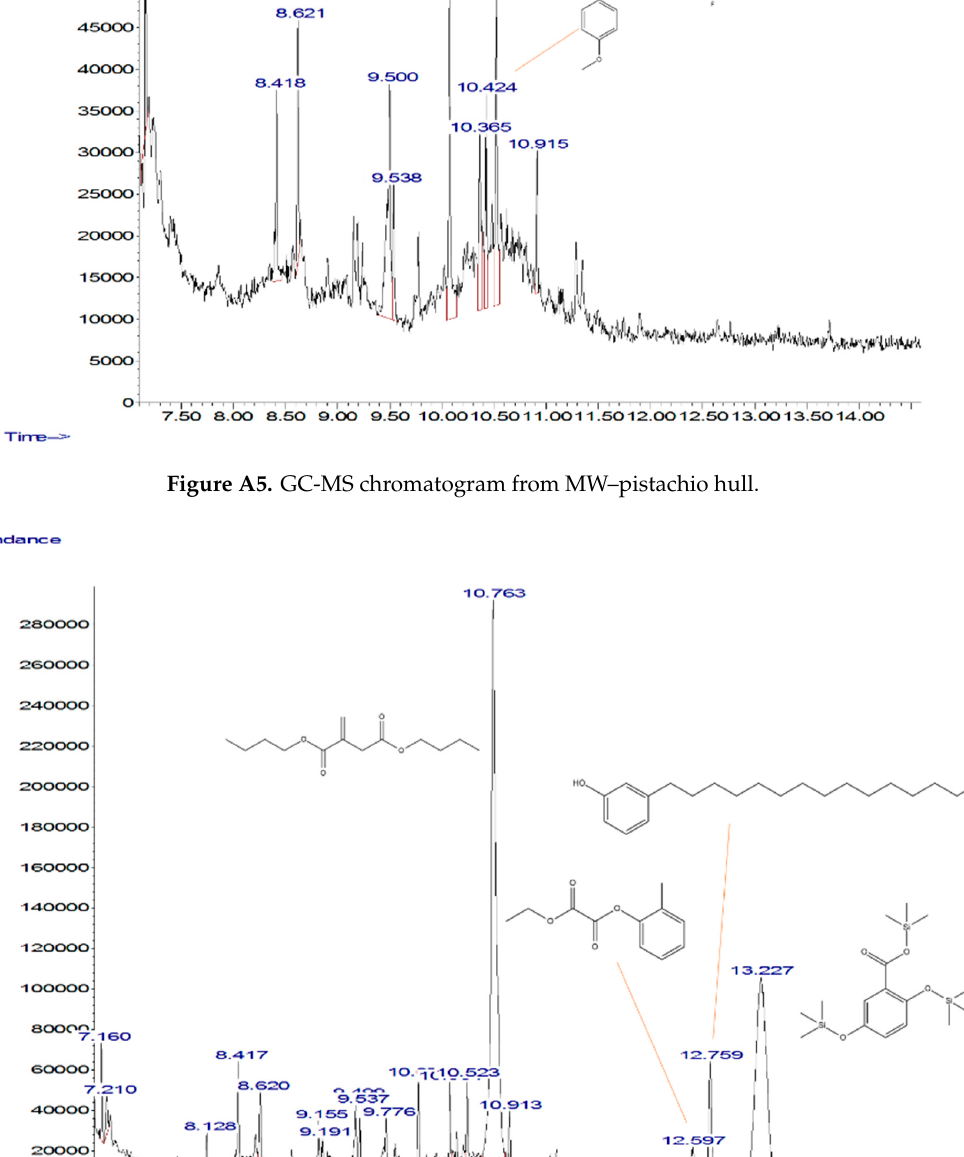
Figure A6. GC-MS chromatogram from MW–SCG.